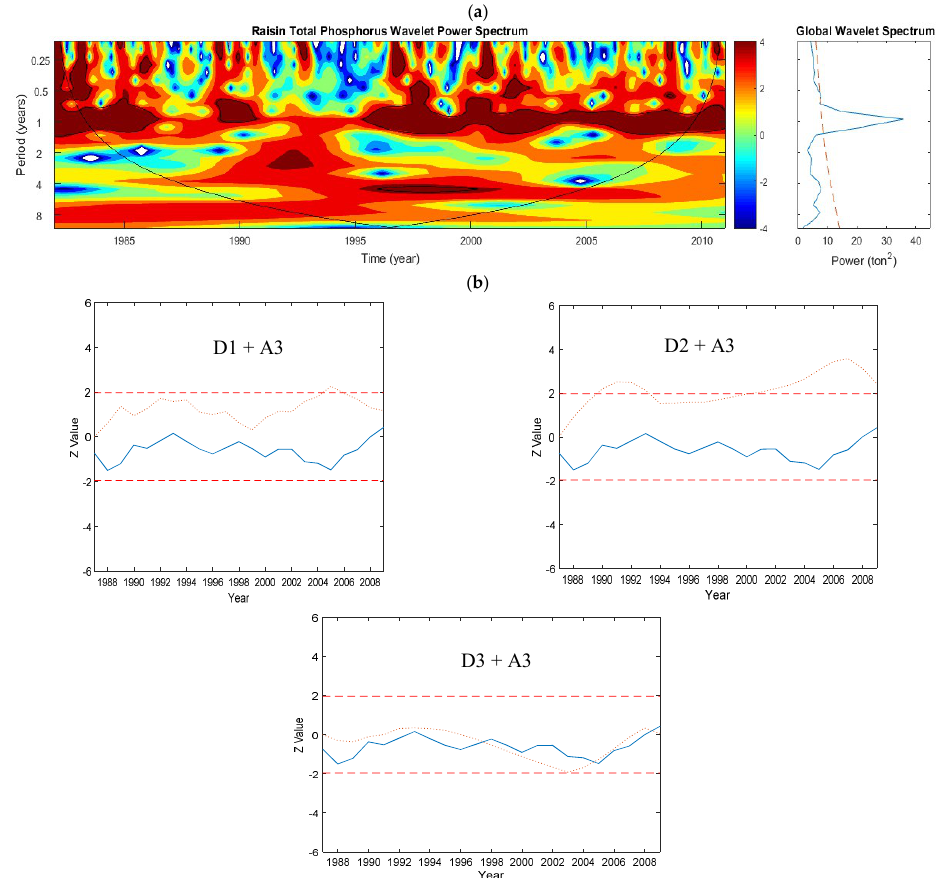
Figure 3. Raisin River: ( a ) Wavelet power spectrum of daily total phosphorus (TP), ( b ) Plots of the sequential Mann–Kendall analyses on the Details (with added Approximation component) of the annual TP data. The top and bottom dashed lines are ±1.96, which are the confidence limits of the MK test using α = 5%. The solid and dotted lines show the sequential MK values for the original data and the Detail components, respectively. For this TP data, the D1 (2 years) and D3 (8 years) components were the most dominant periodicities for the trend.